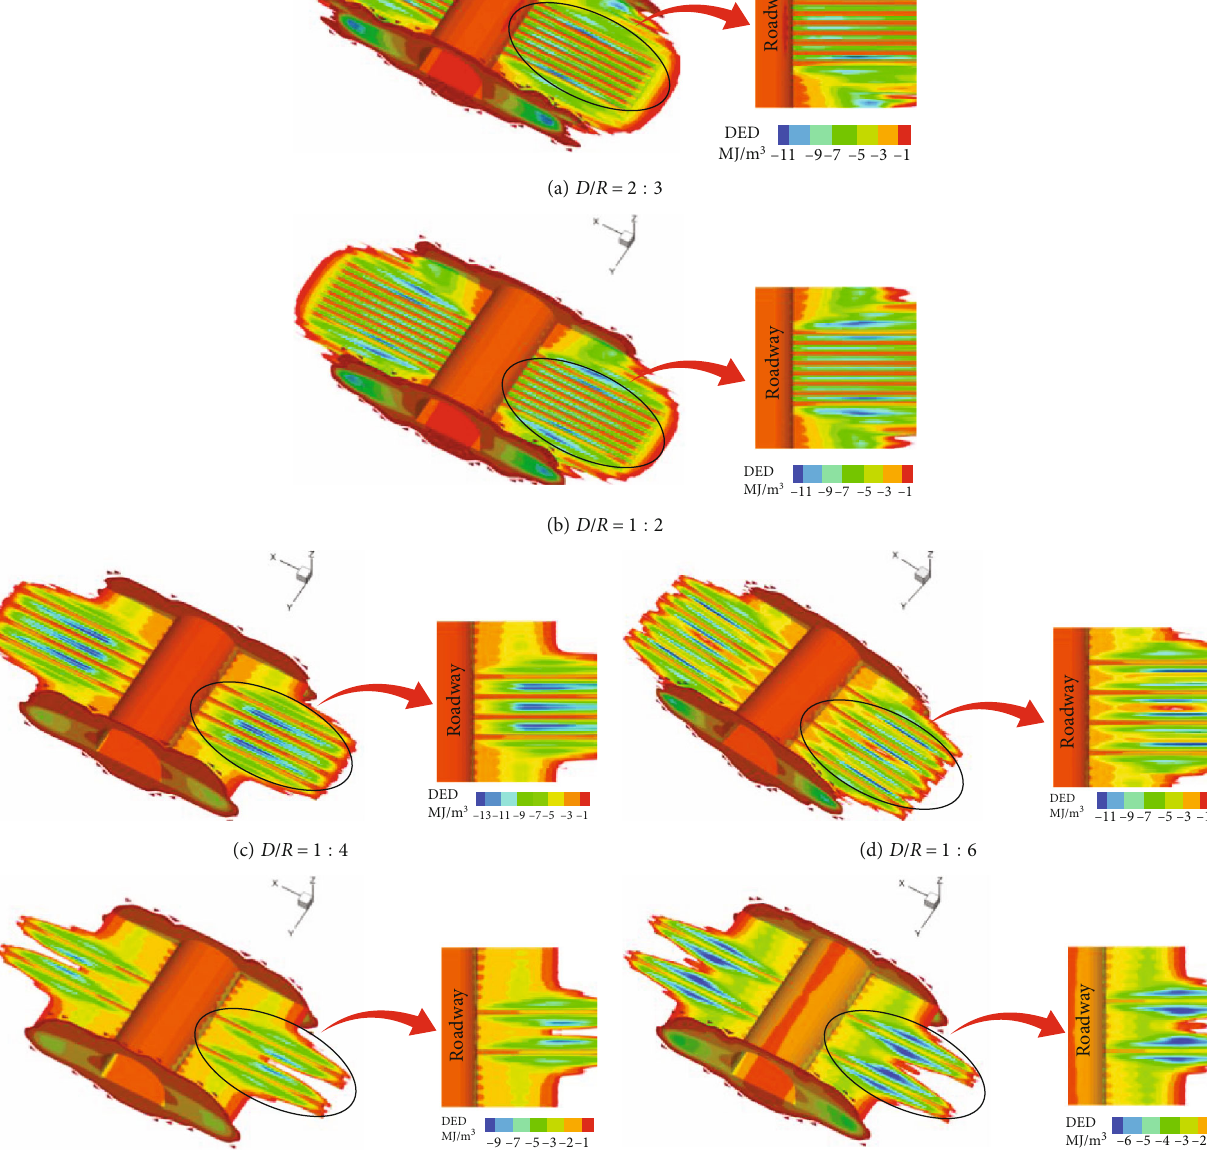
Figure 6: Dissipated energy density (DED) distributions of roadway under di ff erent borehole D / R ratios. Note that the data were obtained from the pro fi le as shown in B-B ′ of Figure